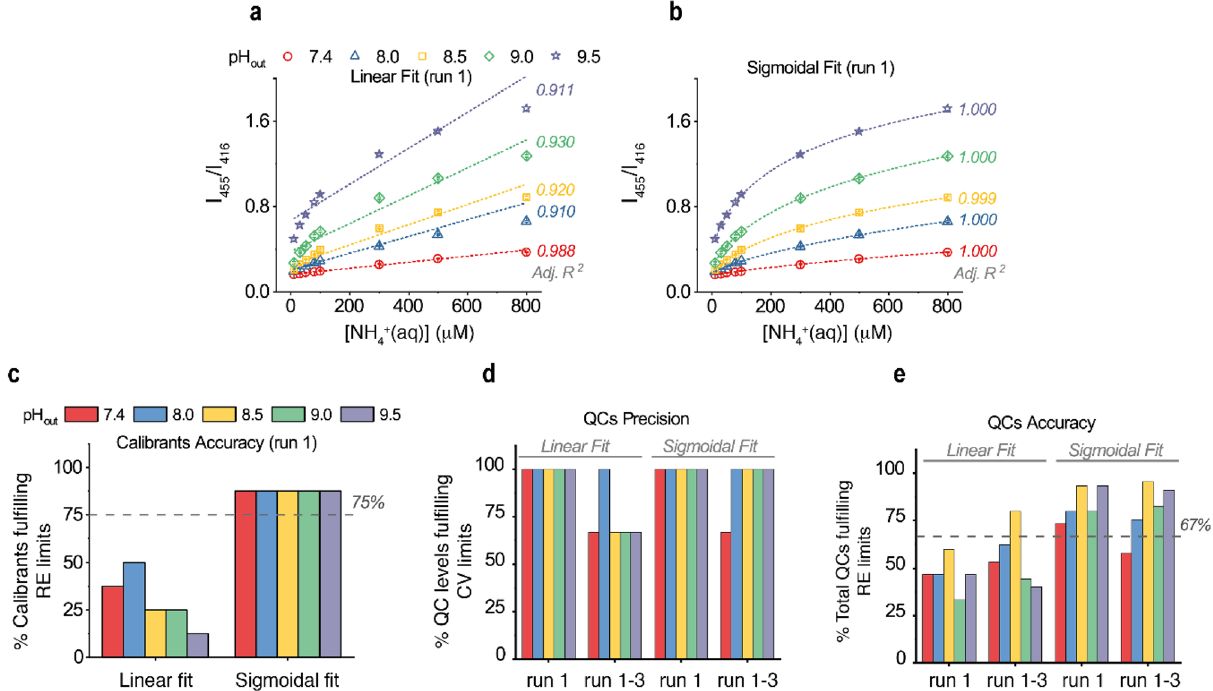
Figure 2. Performance of regression, accuracy, and precision of the PoSo-HPTS ammonia assay using varying pH out . ( a–b ) Measured fluorescence intensity ratios I 455 /I 416 (λ em = 515 nm) (symbols) as a function of [NH 4 + (aq) ] in calibrant solutions (10–800 μΜ in PBS) using PoSo-HPTS with pH in 6.2 and various pH out . Calibration curves and coefficients of determination (Adj. R 2 ) were obtained with either linear ( a ) or sigmoidal ( b ) regression. For each pH out , results are presented as mean ± SD (n = 3) of replicate wells from one experimental run (run 1). In total three independent runs were performed (runs 1, 2, and 3). Conditions: [HPTS] in = 1 mM, [HPTS] assay = 0.4 µM, φ = 25 vol%. ( c ) Fraction of calibration levels from ( a , b ) with mean back-calculated [NH 4 + (aq) ] having RE within ± 15% (or ± 20% for LLOQ). Dotted line indicates the minimum acceptable fraction according to EMA 24 and FDA 23 . ( d ) Fraction of QC levels (60, 400, and 750 μM NH 4 + (aq) in PBS; n = 5 independent replicates per level) with assay-determined [NH 4 + (aq) ] having CV within ± 15%. ( e ) Fraction of total QCs (3 levels, n = 5 independent replicates per level) with assay-determined [NH 4 + (aq) ] having RE within ± 15%. Dotted line in ( e ) indicates the minimum acceptable fraction according to EMA 24 and FDA 23